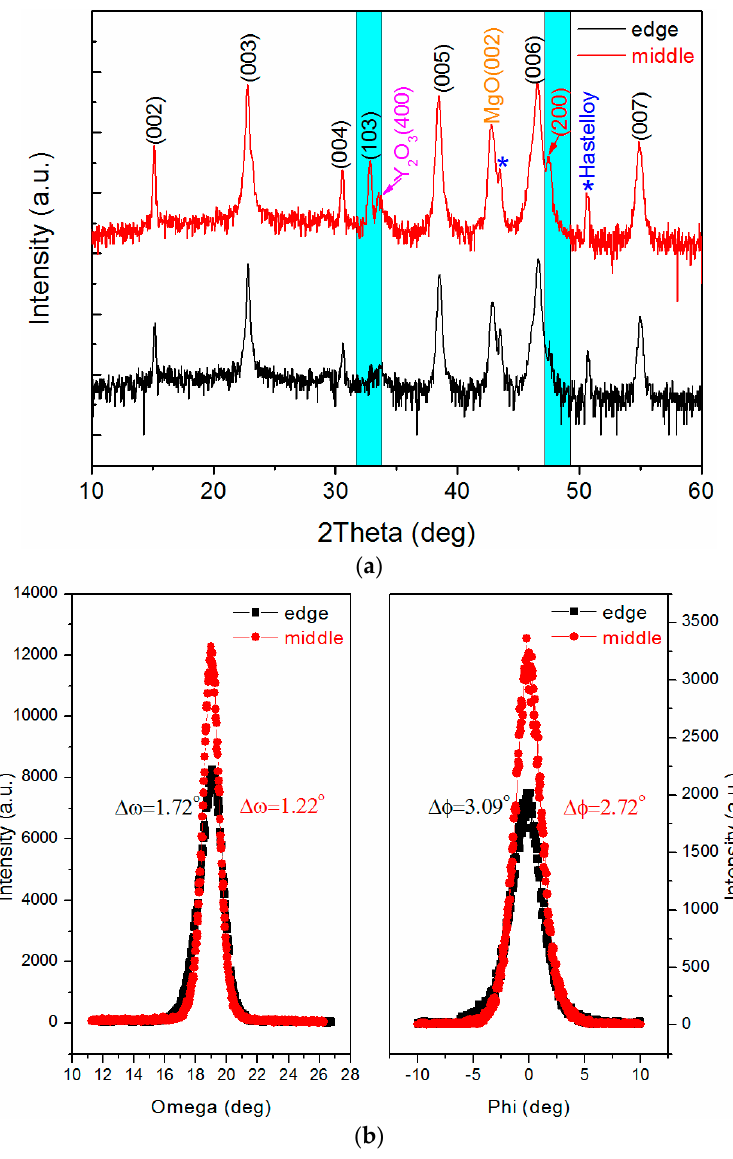
Figure 5. ( a ) The XRD θ –2 θ scanning patterns of the GdYBCO samples prepared based on the slit shower; ( b ) The XRD ω -scan of GdYBCO (005) and the XRD φ -scan of GdYBCO (103).